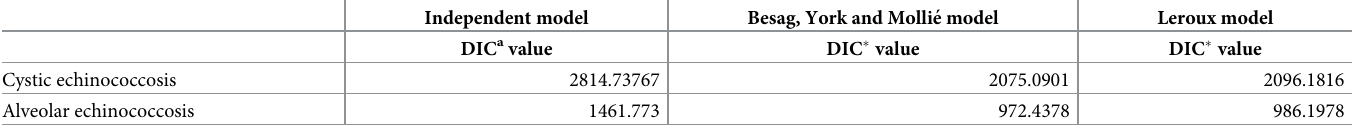
Table 2. Deviance information criterion value of six types of conditional autoregressive models for cystic echinococcosis and alveolar echinococcosis in Kyrgyzstan, 2014-2016. Independent model